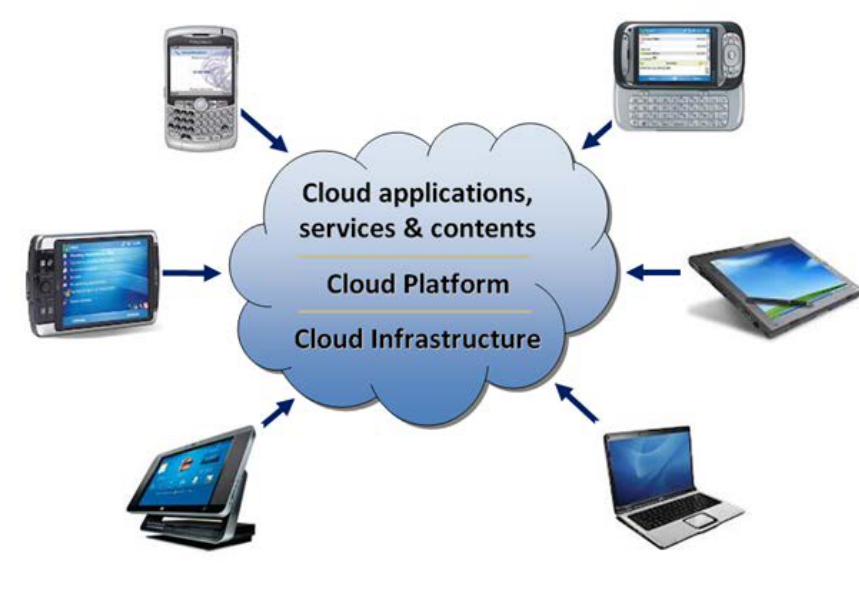
Figure 1 . The concept of mobile cloud learning (Hirsch & Ng,